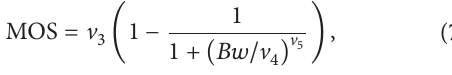
Figure 4: Available bandwidth estimation using packet train